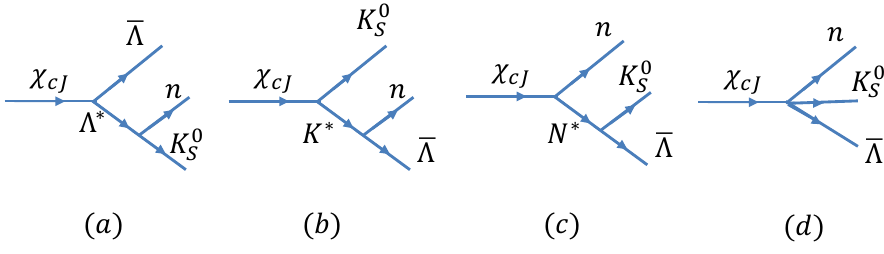
Figure 6 . The quasi-two body decays and the direct three-body decays in the process χ cJ → nK 0